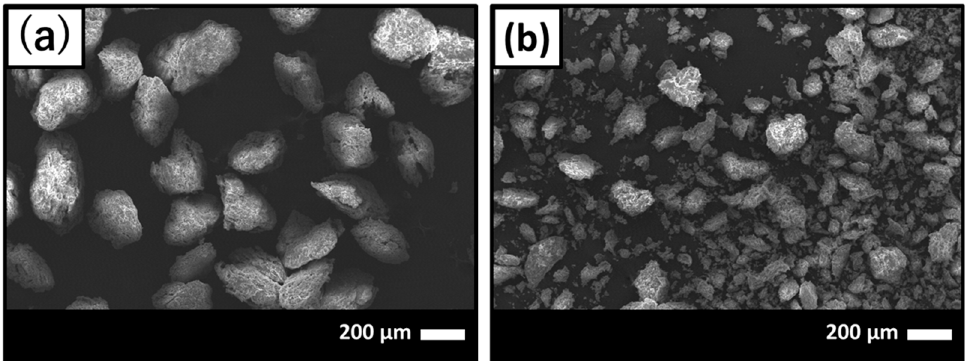
Figure 1. Scanning electron micrographs of ( a ) before and ( b ) after gentamicin sulfate (GNT) loading on hydroxyapatite (HAp)/collagen (Col) powder.